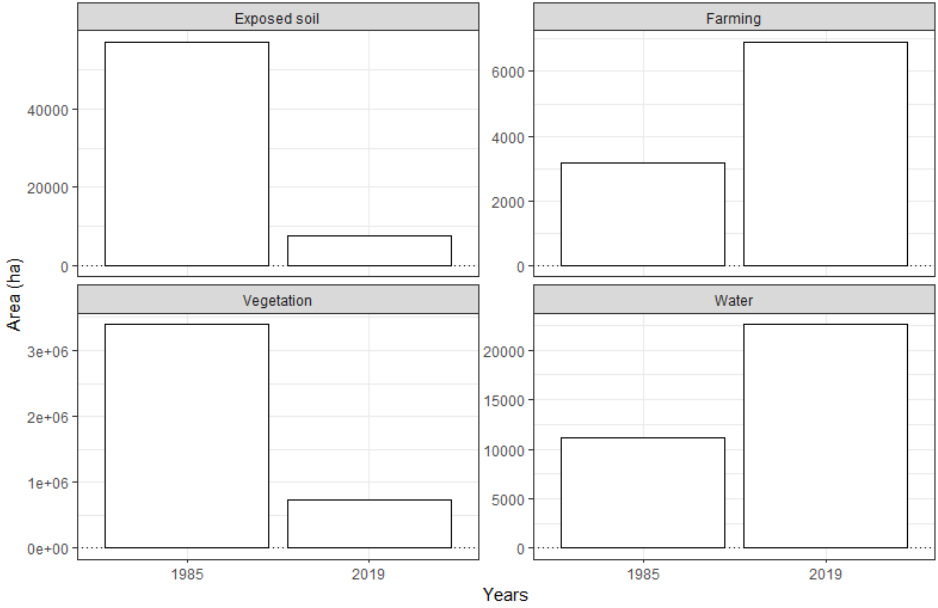
Figure 3. Dynamics and quantification of thematic classes through digital classification in the municipality of Floresta-PE.